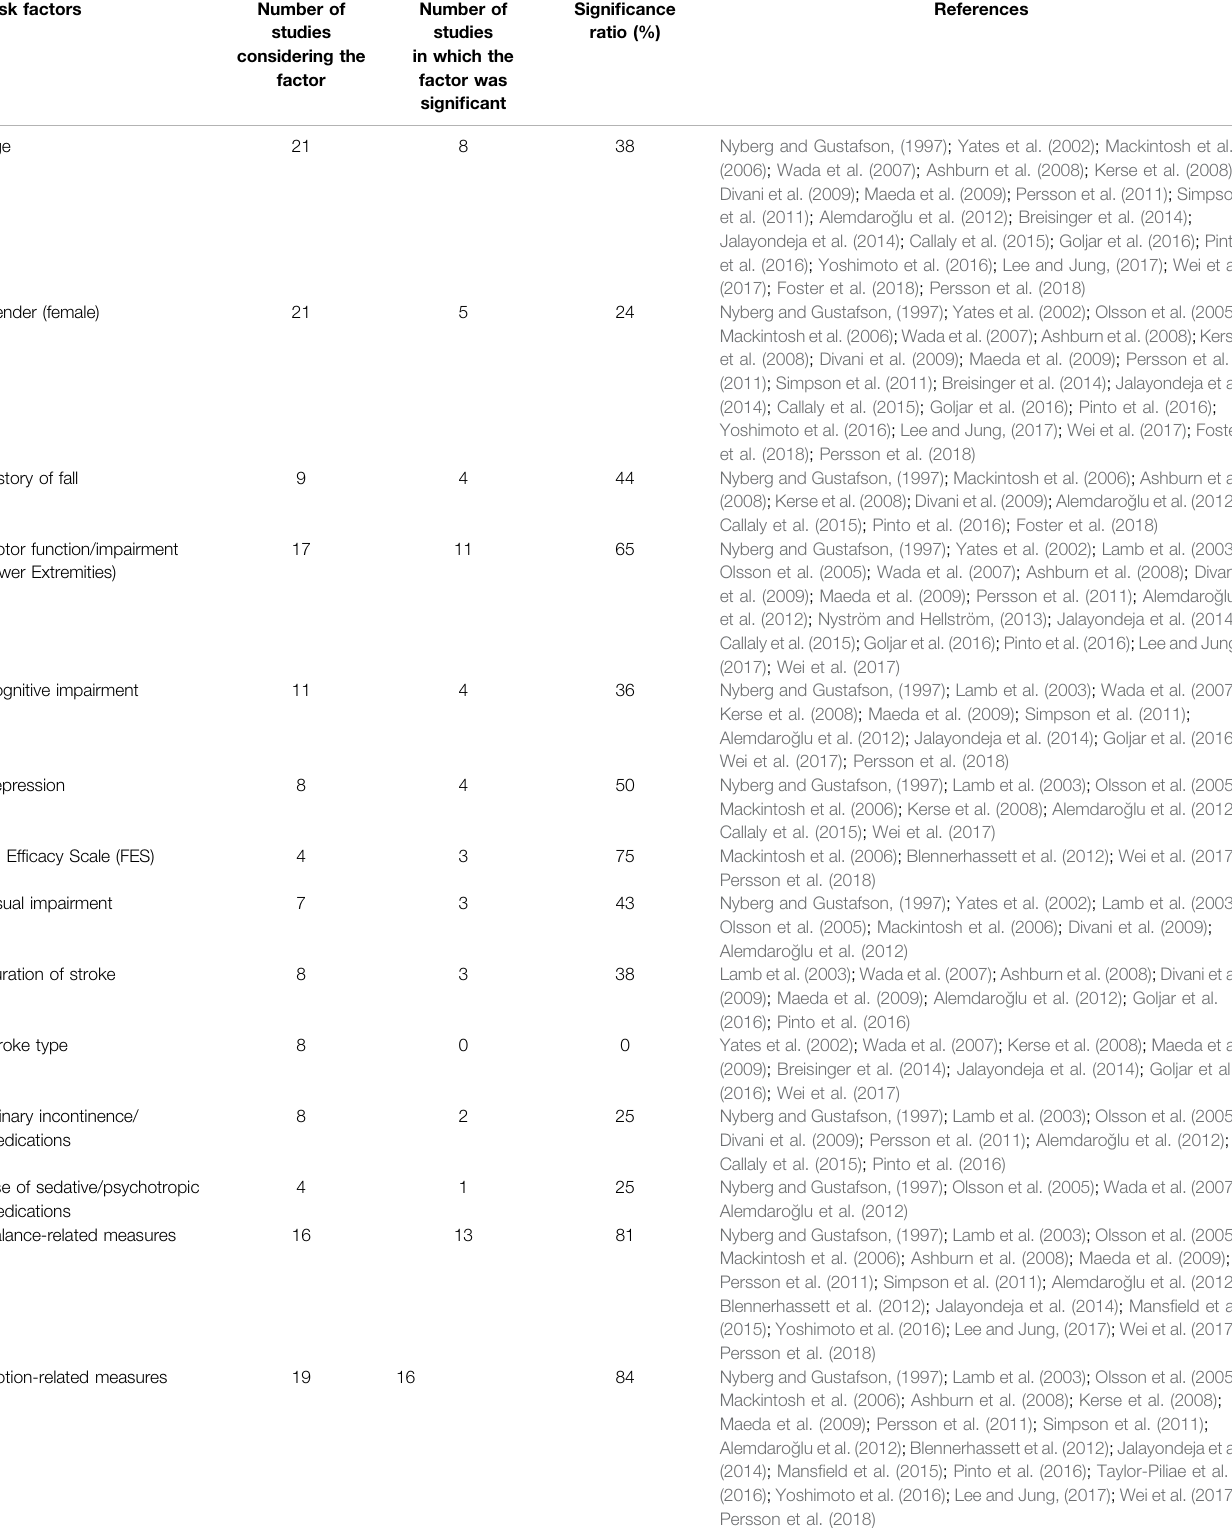
TABLE 3 | Commonalities among the 14 most signi fi cant FRFs in the